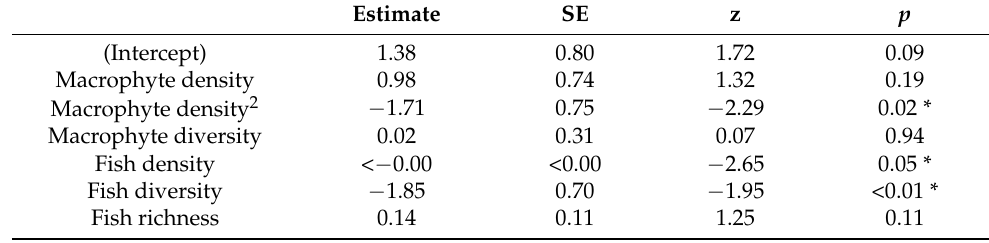
Table 4. Results of beta regression analysis for trophic niche breadth, assessed by Pianka’s Index (mO), considering a general mean. * = statistically significant values.